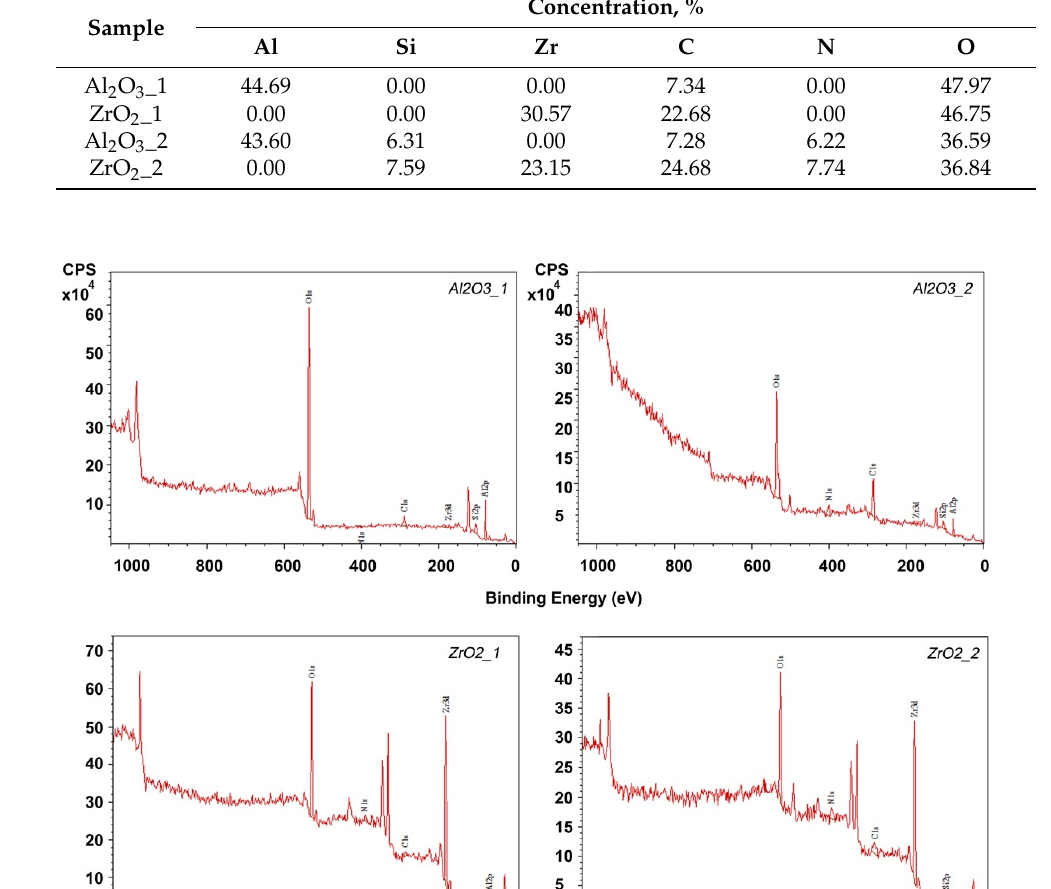
Table 6. XPS concentration of raw and modified ceramic powders.